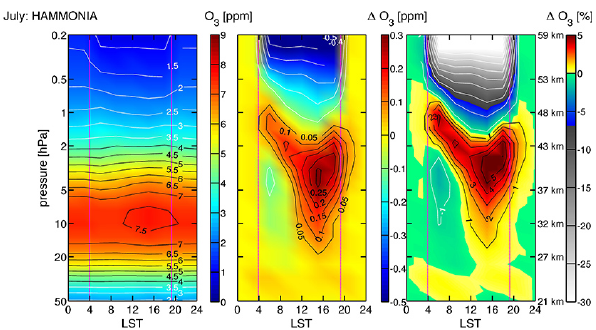
Figure 5b. Mean diurnal ozone variation of HAMMONIA between 50 and 0.2hPa for July. The left, middle and right panel are de- scribed in Fig. 4a.